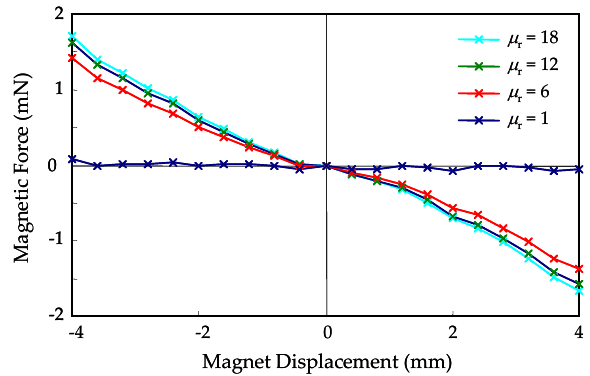
Figure 9. Magnetic force on magnet with 2 h = 6 mm due to embedded FF.